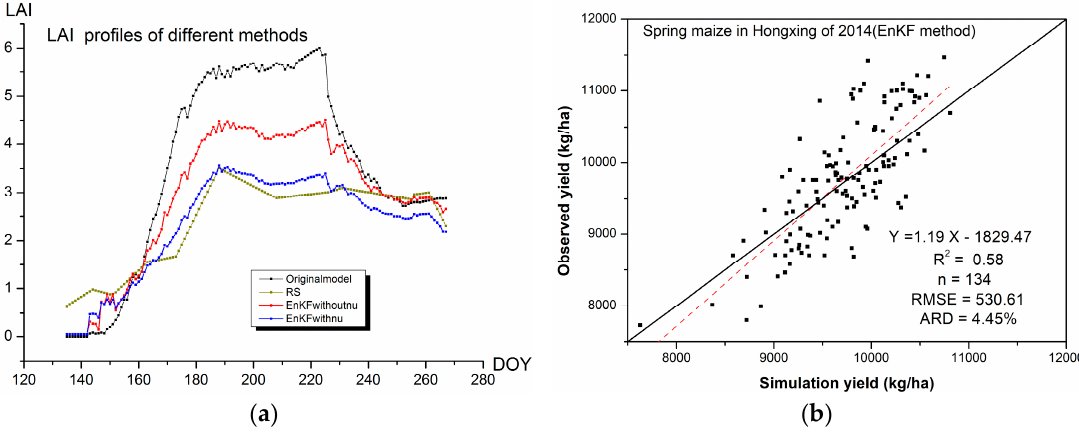
Figure 7. Analysis results of actual crop growth simulations. ( a ) LAI profiles (Original model represents the water-limited crop growth simulation of the original WOFOST model, RS represents the RS empirical regression model estimation, EnKF withoutnu represents the assimilation of RS-simulated LAI with water-limited LAI, and EnKF withnu represents the assimilation of RS-simulated LAI with mean nutrient-limited LAI); ( b ) The yield simulation accuracy with the EnKF method.